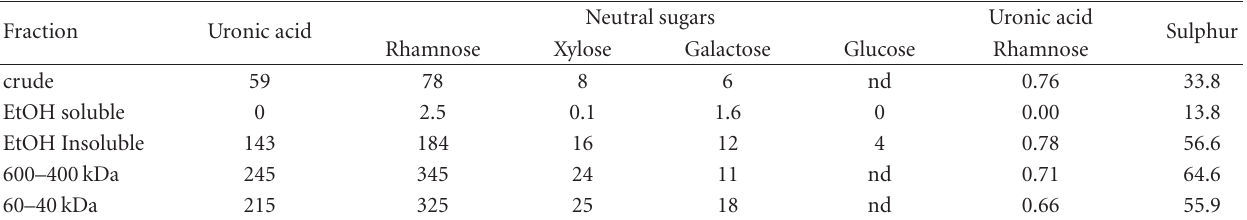
Figure 1: Biochemical analysis and biological activity of fractions from green algae Ulva spp. (a) Size exclusion chromatography of the high molecular mass compounds present in the ethanol-insoluble fraction recovered from the crude extract. Fractionation was followed by glucuronic measurement. (b) FITR spectra of the 600–400 kDa fraction. The peaks at 847, 1052, 1256, 1641, and 3446 cm − 1 are respectively generated by the bending vibration of C–O–S in axial position, the stretching vibration of C–O, S–O, C = O, and C–OH, all linkages being present in the constitutive dimer β -D-glucuronosyl-(1,4)- α -L-rhamnose-3-sulfate. (c) Biological activity of the crude extract and fractions. GUS activity was measured on P1Lox::GUS transgenic tobacco 3 days after infiltration in leaves of the various samples (1mg · ml − 1 ) as indicated. Means, for each treatment compared to the control mean using a Student’s t -test. Treatment associated to a P -value ≤ . 05 or ≤ . 01 was marked, respectively, by ∗ or ∗∗ . Table 1: Chemical composition of an Ulva spp. crude extract and fractions obtained by ethanol precipitation and size-exclusion chromatography (mg · g − 1 of dry